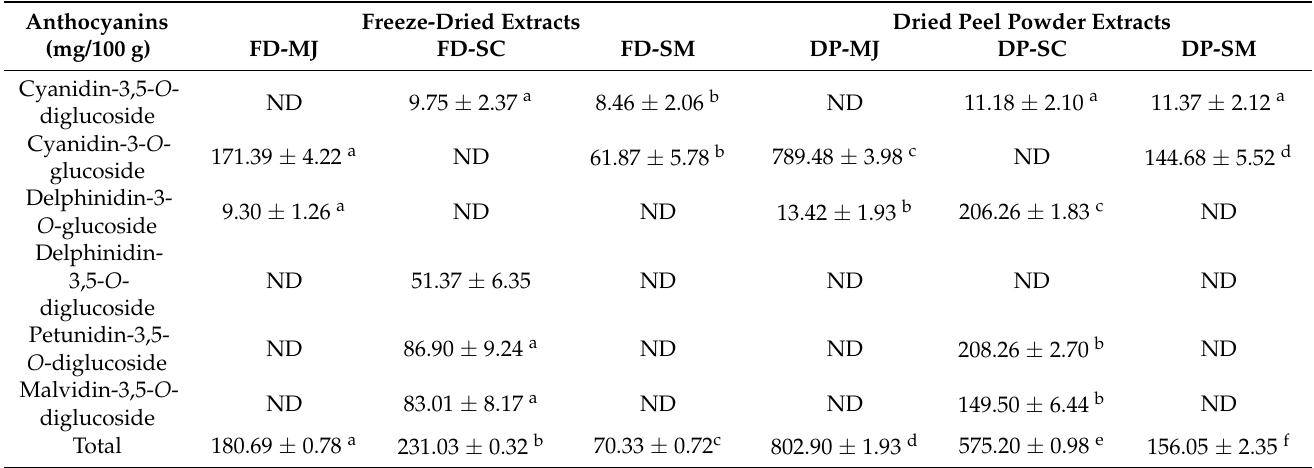
Table 2. The anthocyanins concentration on freeze-dried (FD) and dried peel powders (DP) extracts of M. jaboticaba (FD- MJ and DP-MJ), S. cumini (FD-SC and DP-SC), and S. malaccense (FD-SM and DP-SM).